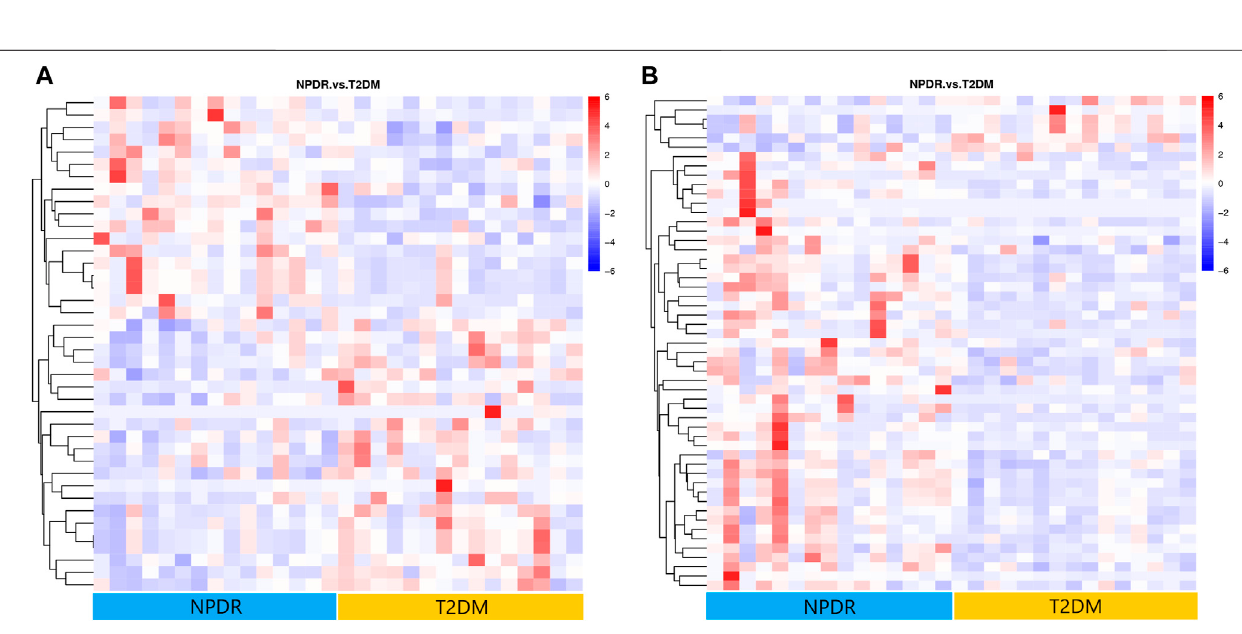
FIGURE 3 | (A) Positive mode. (B) Negative mode. Hierarchical clustering analysis based on the intensity of signi fi cant metabolite features selected by PLS-DA identi fi ed clustersof features that wereincreased (red) or decreased (blue) in NPDR and T2DM patients. There are 40metabolic featuresshown in positive modeand 53 metabolic features shown in negative